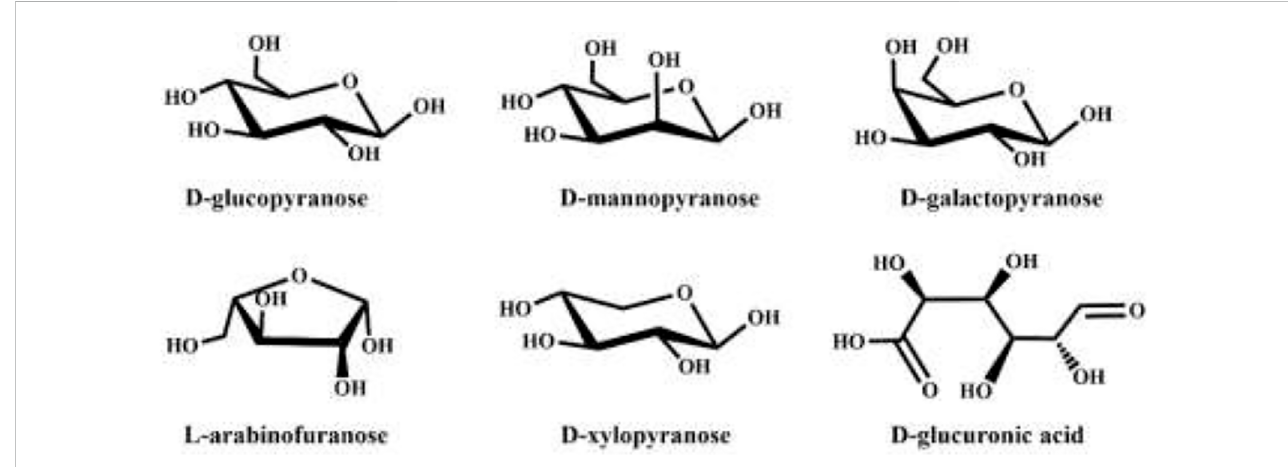
FIGURE 1 The monosaccharide composition of hemicellulose reproduced from: Kong et al. (2018),